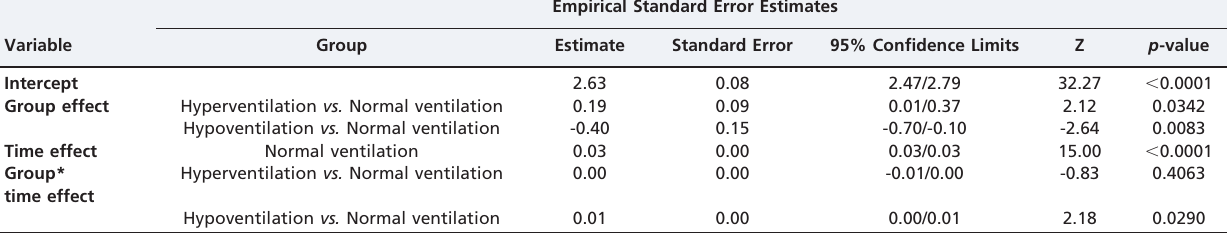
Table 3 - Generalized estimating equation analysis for the arterial desflurane concentrations between the hyperventilation and hypoventilation groups compared with the normal